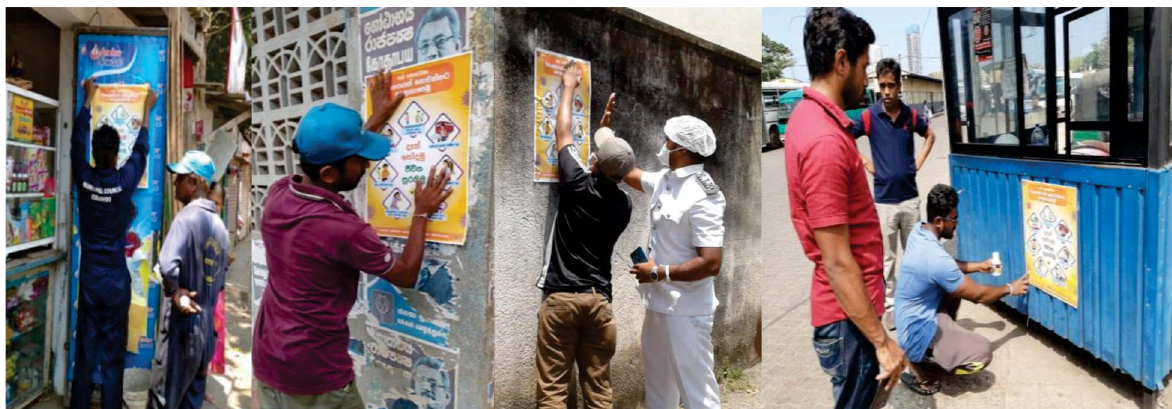
Figure 1: Public awareness on COVID-19 safety measures - poster